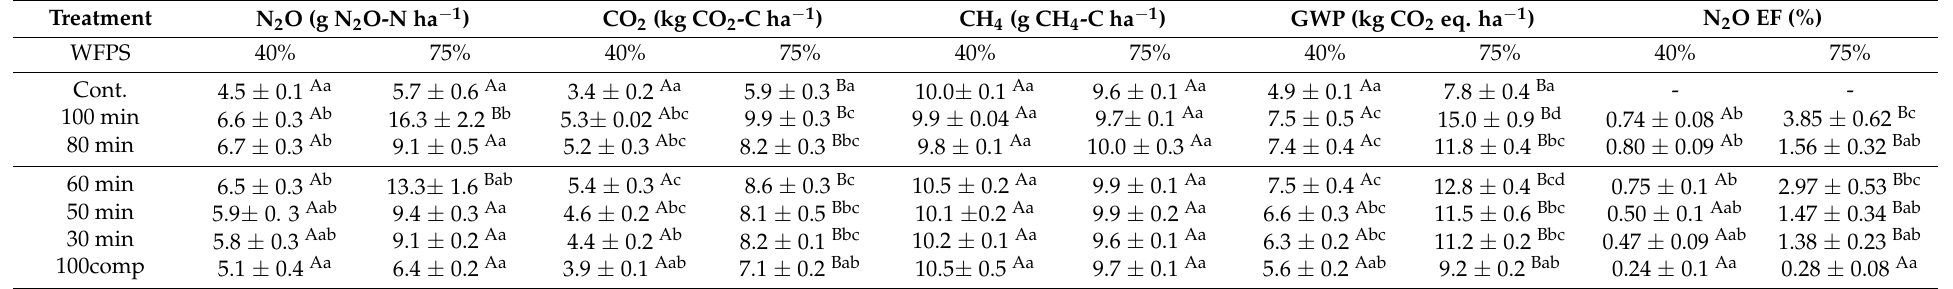
Table 4. Cumulative nitrous oxide (N 2 O), carbon dioxide (CO 2 ), and methane (CH 4 ) emissions, global warming potential (GWP), and N 2 O emission factor (EF) (Mean ± standard error) in different fertilizer types and 40% and 75% water filled pore space (WFPS) for 28 days of incubation. (N =